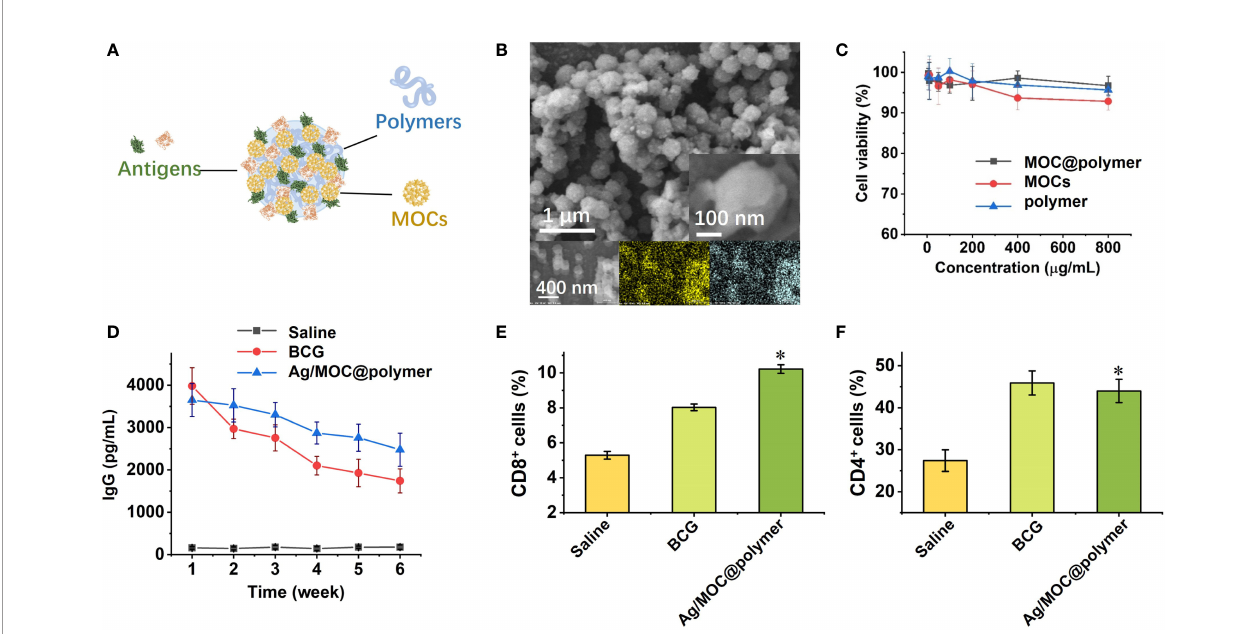
FIGURE 2 | (A) Schematic illustration of self-assembly of virus-mimetic polymeric structures (Ag/MOC@polymer supra-molecular particle assemblies; Ag abbreviated from antigens) for the construction of subunit vaccine (50). (B) SEM image of virus-mimetic polymeric structures. Inset: magni fi ed SEM image of one virus-mimetic polymeric structure. (C) Cytotoxicity of virus-mimetic polymeric structures on murine bone marrow derived dendritic cells (BMDC) assessed using the colorimetric cell counting kit-8 (CCK-8). (D) Serum TB-speci fi c IgG titres over time after inoculation of virus-mimetic polymeric structures. Count rates of CD8 + (E) and CD4 + cells (F) in Balb/c mice spleen by fl ow cytometry one week after inoculation. Each data shows mean ± s.e.m. from a representative experiment (n = 6 for each group) out of three independent experiments. * p < 0.05, are analyzed by one-way ANOVA. * Indicates statistically signi fi cant differences between tested groups and saline